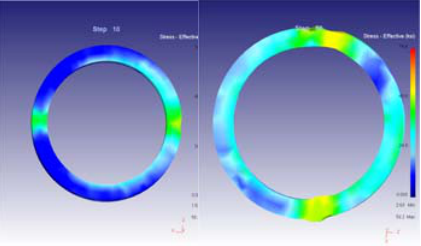
Fig. 14. The strain distribution of rolling stage